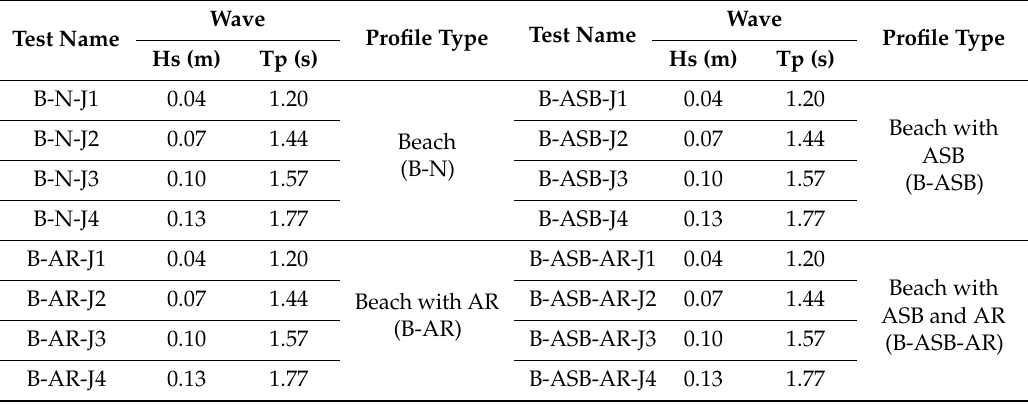
Table 1. Physical experimental tests (N represents mild profile part without the o ff shore interventions, and beach with artificial reef (B-AR), beach with artificial submerged sand bar (B-ASB), and B-ASB-AR indicate beach with artificial reef and artificial submerged sand